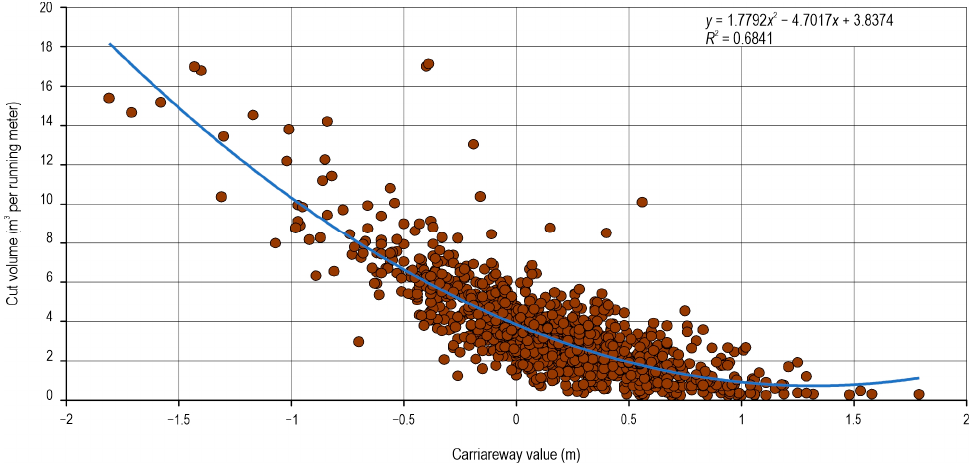
Figure 6. Impact of carriageway value on cut volume.